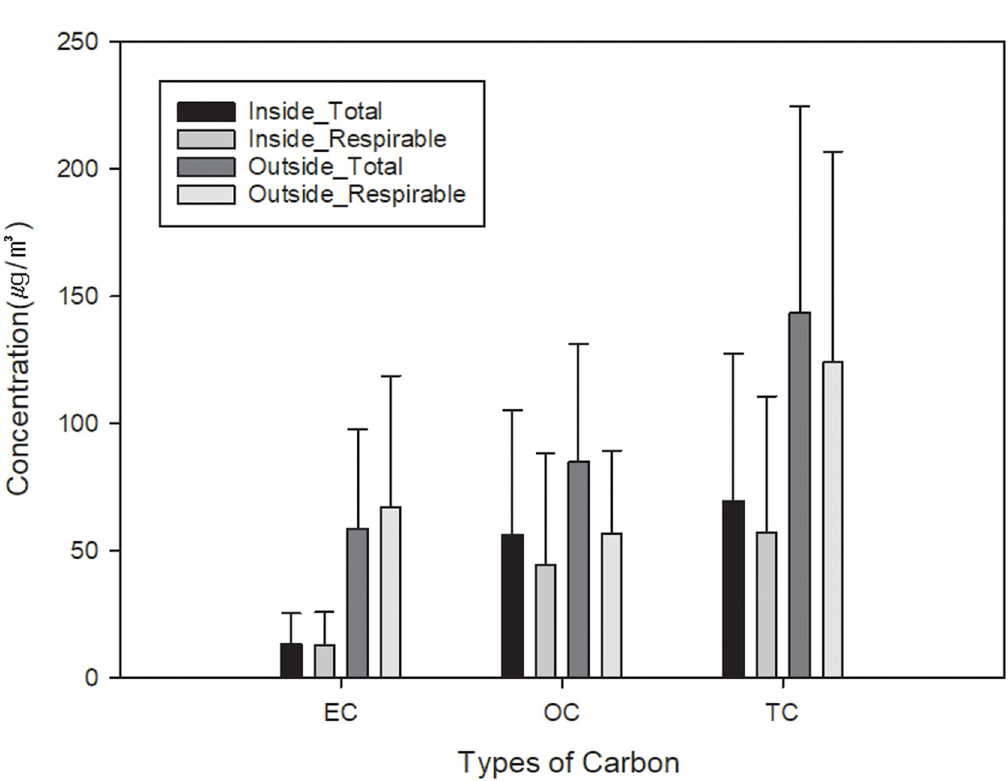
Fig 1. Mean concentration of EC, OC and TC, along with standard deviation (error bar), for each total and respirable particulates from inside and outside the excavator in underground excavation site.